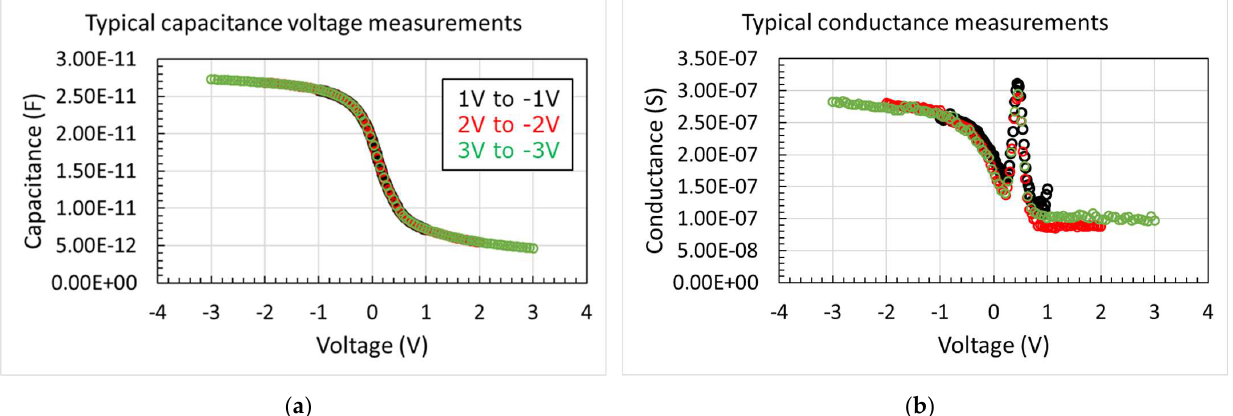
Figure A1. Typical ( a ) capacitance and ( b ) conductance measurements performed in this work. Data shown for Ru/HfO2 combination on a SiO 2 bevel (slant etch) on a p-type Si substrate. The capacitors are sequentially measured at different voltage sweep ranges (i) 1 V to − 1 V, (ii) 2 V to − 2 V, (iii) 3 V to − 3 V.